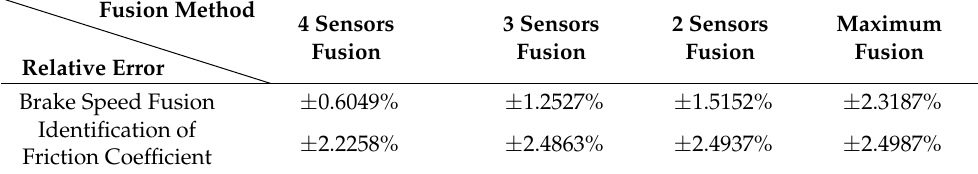
Table 4. Speed fusion errors and parameter identification errors.